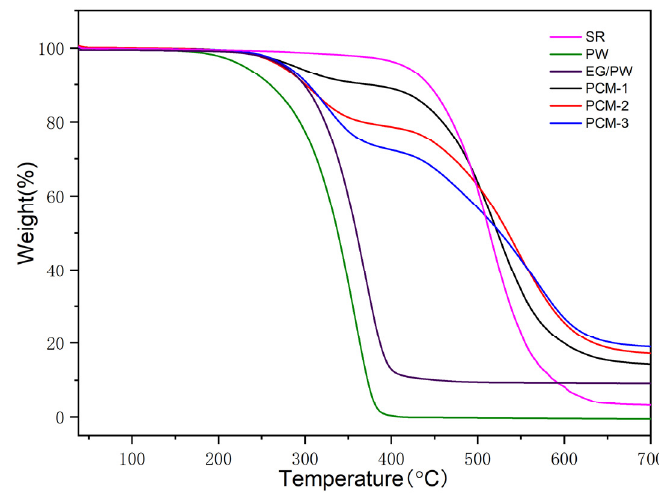
Figure 6. TGA cures of SR, PW, EG/PW and EG/PW/SR composites.